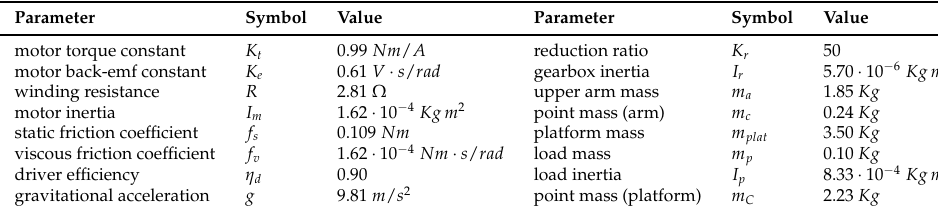
Table 2. Dynamic parameters of the parallel